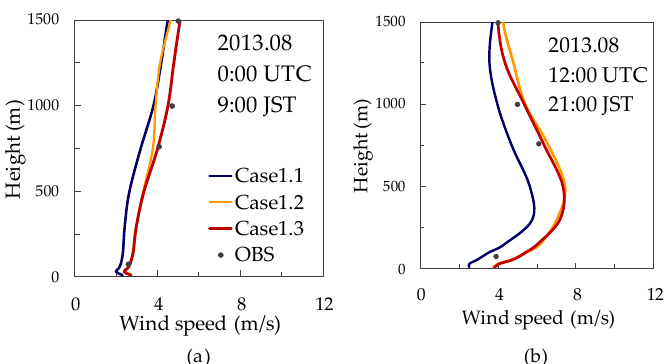
Figure 5. Effect of nudging height on the monthly average wind speed at Tateno: ( a ) 0:00 UTC (9:00 JST) in August 2013 ( b ) 12:00 UTC (21:00 JST) in August 2013.